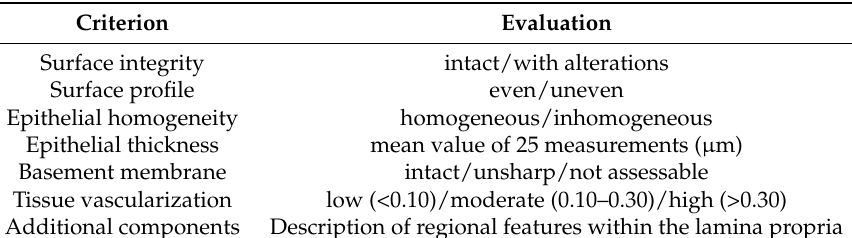
Table 1. Criteria of the OCT image analysis.